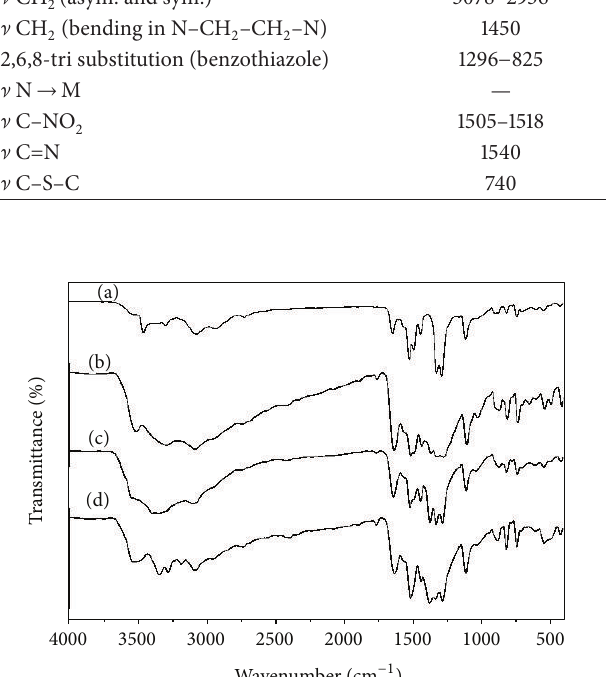
Figure 1: FTIR spectra of (a) BEF, (b) BEF–Cu, (c) BEF–Ni, and (d) BEF–Zn.